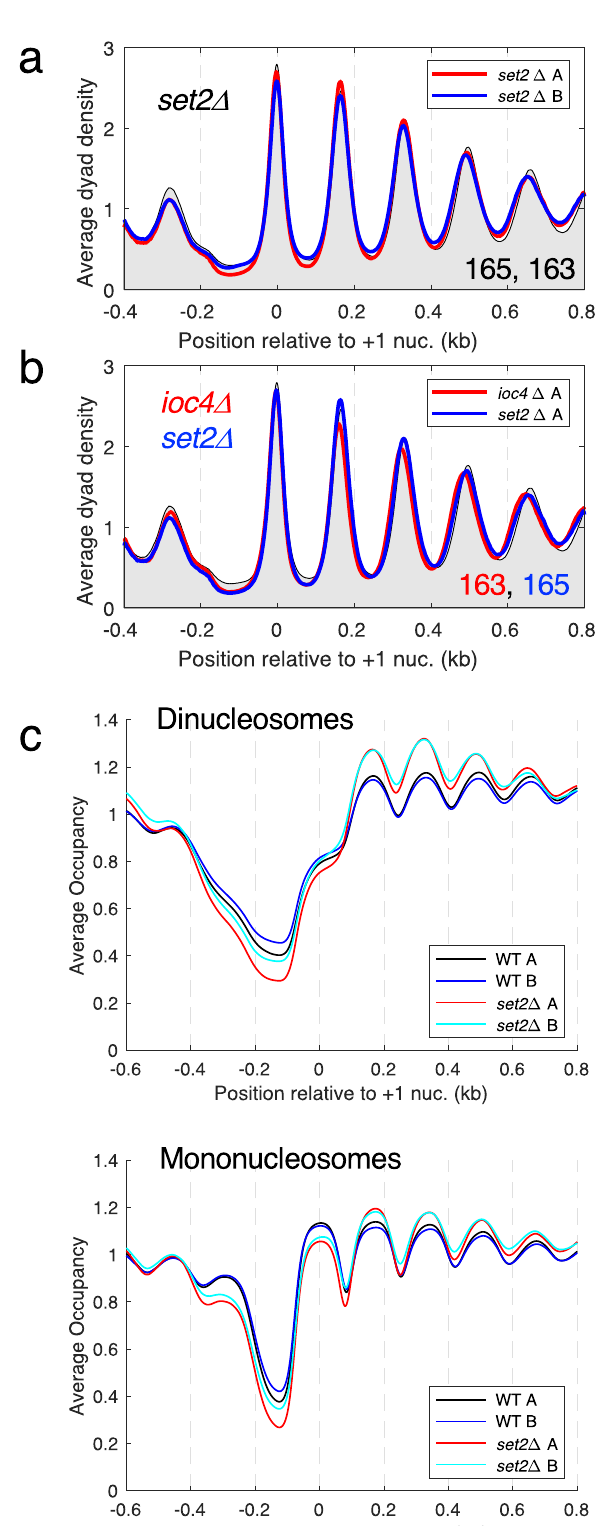
Figure 4. Set2 contributes to dinucleosome separation but has little effect on spacing. ( a ) Average nucleosome dyad density plot for all genes in set2Δ cells. Wild type replicate A is shown as a black line with grey fill. Two biological replicate experiments are shown: A (red line) B (blue line). The average spacing (bp) for replicates A and B is shown (bottom right). ( b ) Comparison of chromatin organisation in set2Δ cells (blue line) and ioc4Δ cells (red line) (replicates A). ( c ) Occupancy plots for dinucleosomes and mononucleosomes in set2Δ and wild type (WT) cells (see legend to Fig.